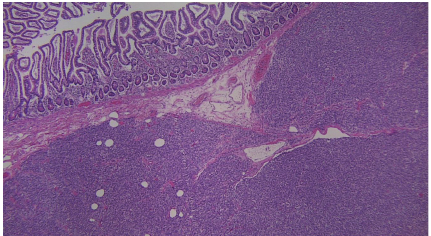
Figure 3: The largest metastatic deposits involve the full thick- ness of the bowel wall and demonstrate luminal ulceration and have caused intussusception and obstruction. The overwhelming majority of the tumor is viable. Arterial and venous invasion are